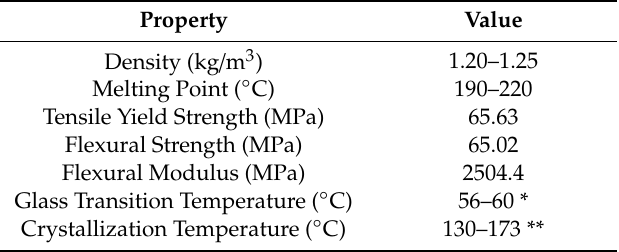
Table 2. Data sheet of the Polylactide acid (PLA) filament employed [38].